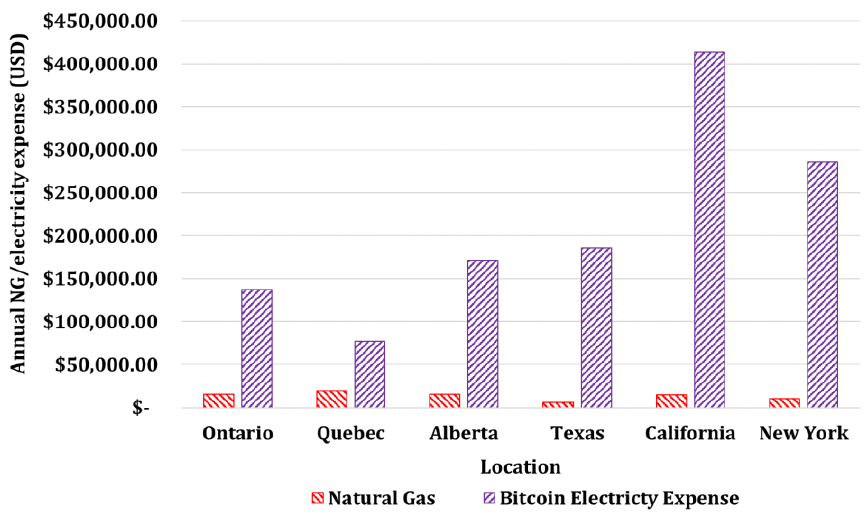
Figure 32. Annual heating expense of natural gas compared to electricity used to operate a Bitcoin mining system in six North American locations to heat Greenhouse 2. Electricity expense compared to natural gas expense in six distinct locations for Green- house 3 is summarizedin Figure 33.